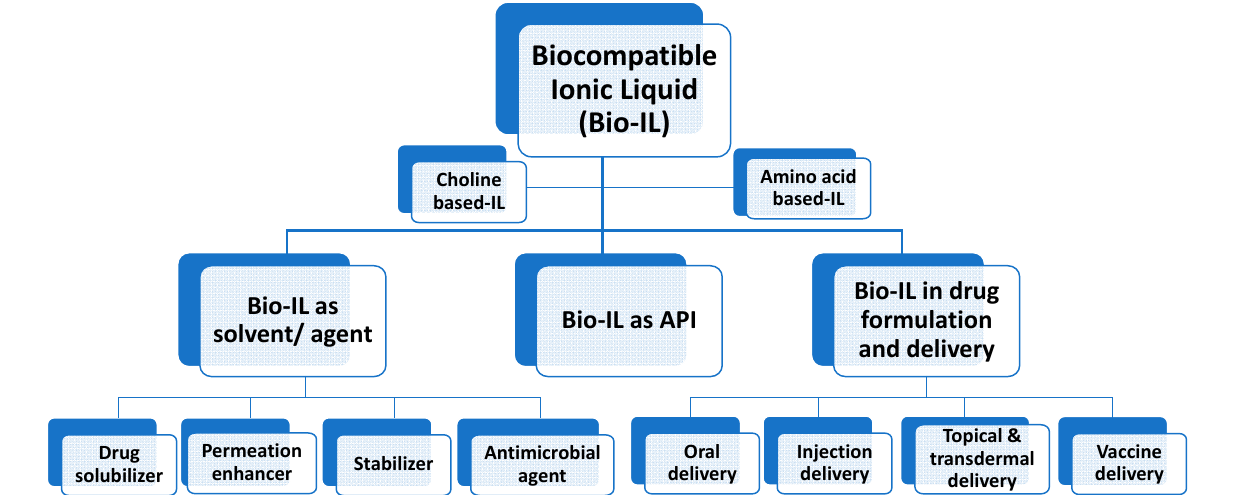
Figure 1. Applications of Bio-IL in drug formulation and delivery systems.